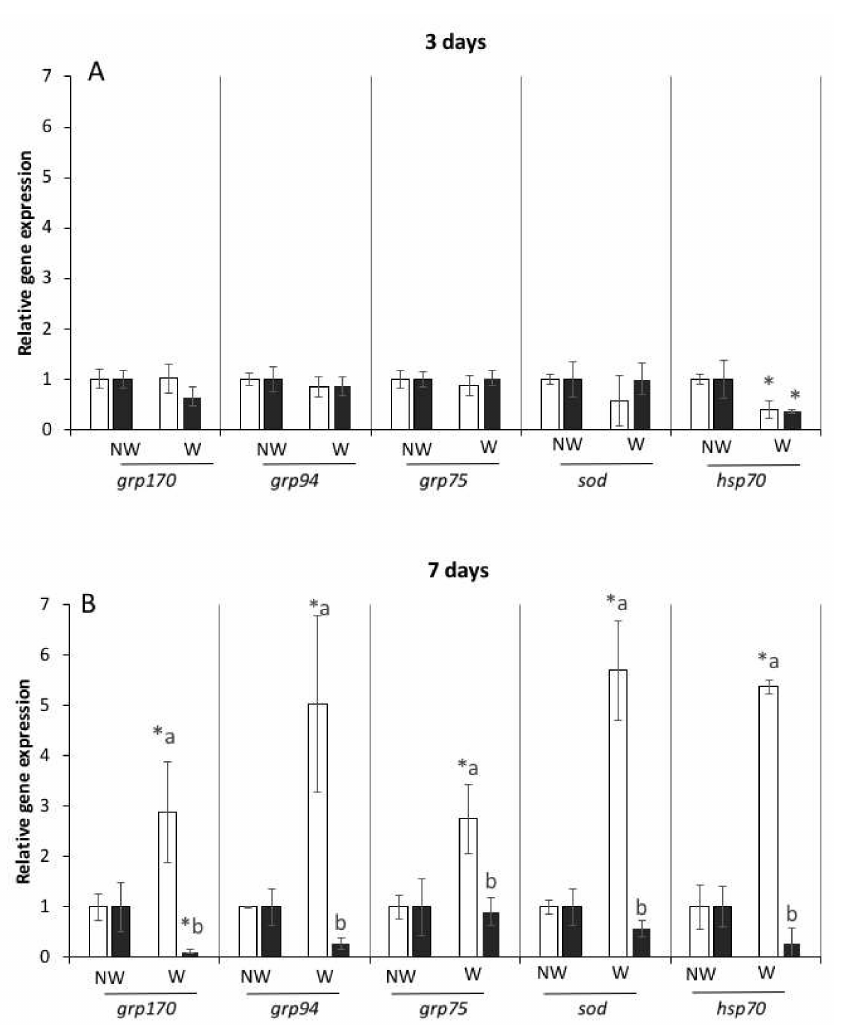
Figure 2. Expression levels of stress-related genes in the skin of both flanks in the non-wounded (NW, control) and wounded (W) fish (left side (with wound in wounded fish) or right side (without wound)). Values are presented as mean ± SEM ( n = 5). Differences between flanks are indicated by different letters; differences between groups (wounded or non-wounded fish) are indicated by asterisks ( p <